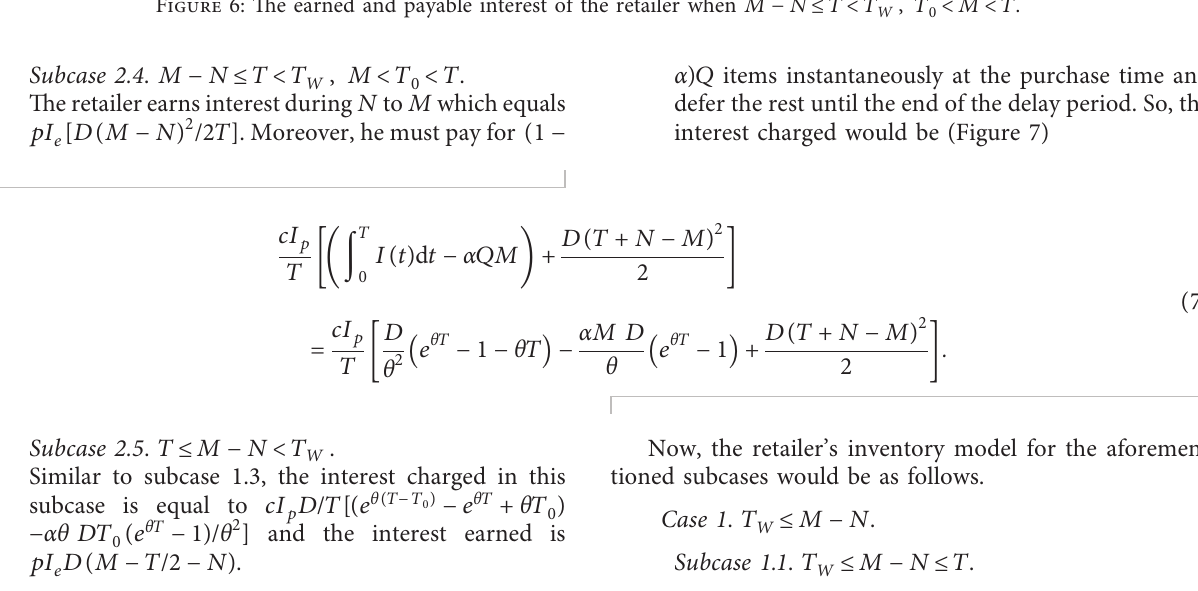
Figure 6: The earned and payable interest of the retailer when M − N ≤ T < T